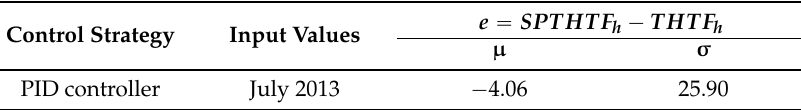
Table 6. Numerical results of simulation with PID (July